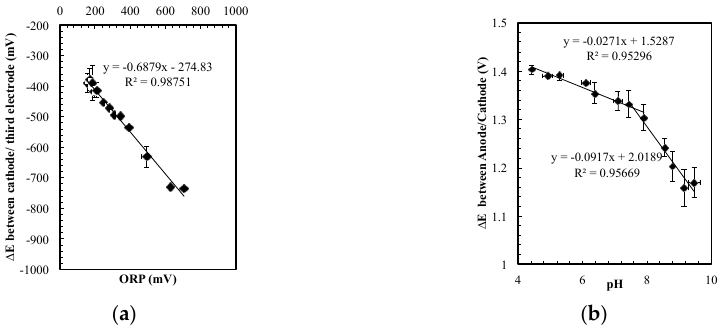
Figure 3. ( a ) The potential difference between the third electrode and the cathode indicates oxidation-reduction-potential (ORP); ( b ) The potential difference between cathode and anode was a pH indicator in various chloride concentrations.